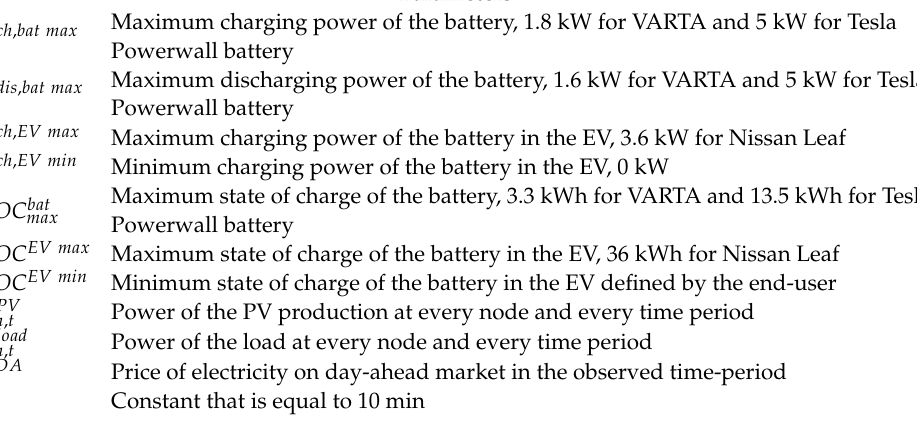
Figure A2. Load profile curve—August. Figures A3 and A4 represent the PV production profile curve on the ten-minute basis for every day in the week in January and August. The PV production power of the end- user with the installed PV was calculated from the daily PV production profile curve.